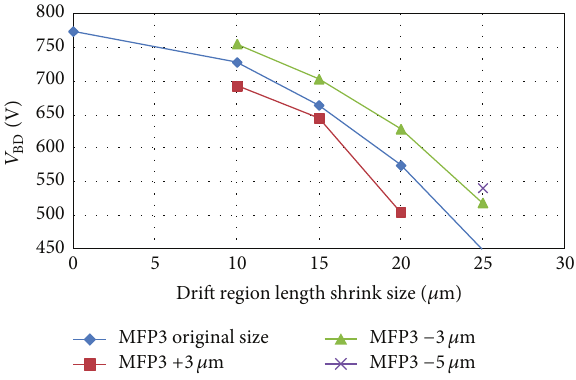
Figure 2: Breakdown voltage related to different drift